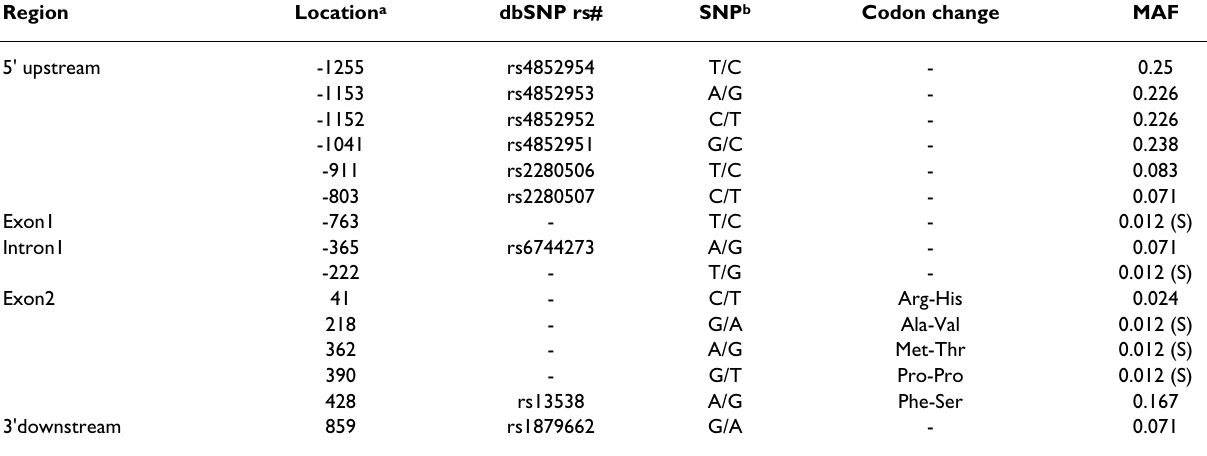
Table 2: NAT8 genomic region SNPs identified by resequencing in random Estonian population samples (n = 42)